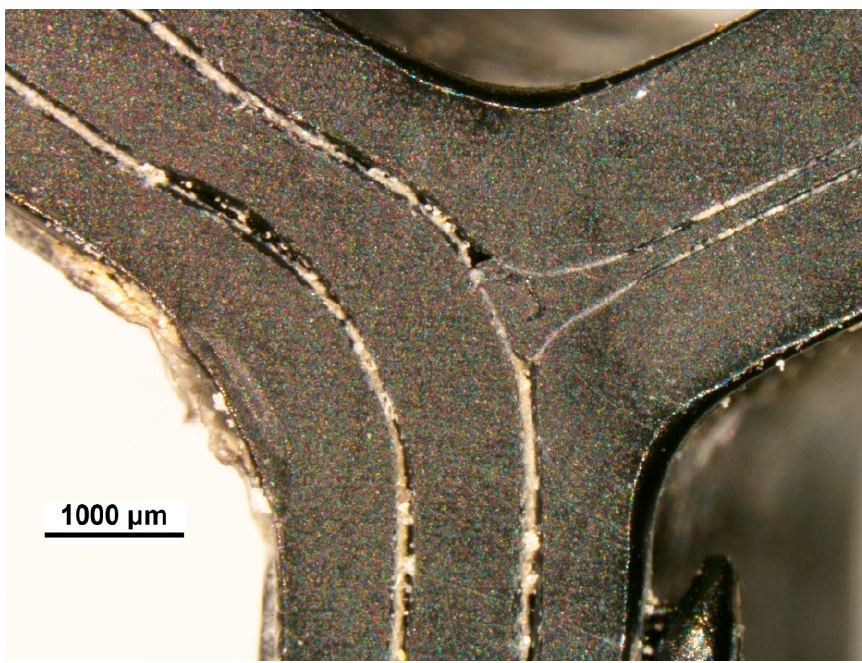
Figure 2. Microscopic view of three-layered printed hexagon walls.